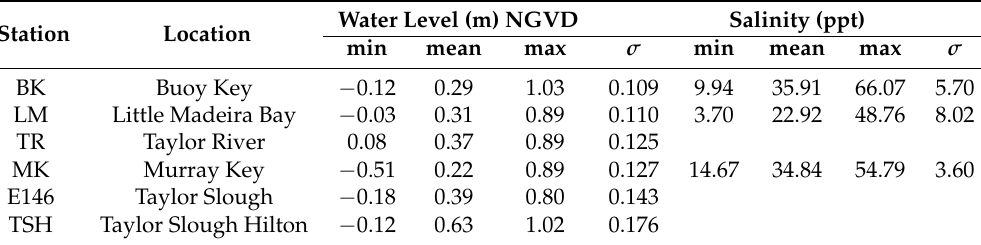
Table 2. Station time series statistics.